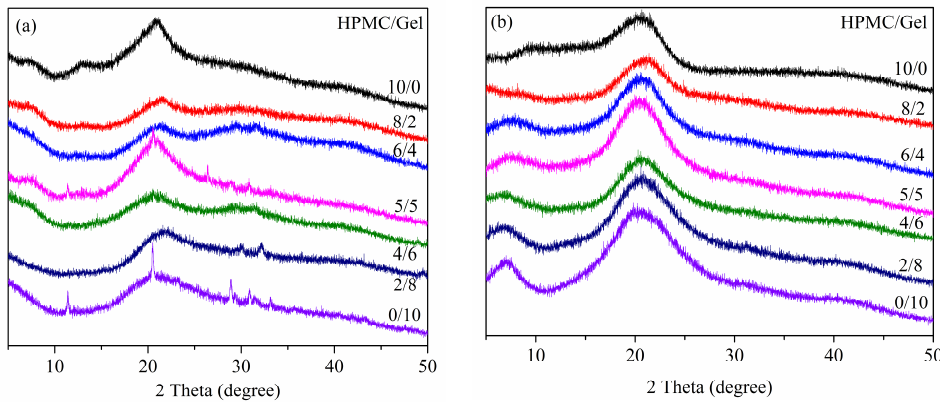
Figure 3. XRD patterns of HPMC and Gel blended film: ( a ) natural dry; ( b ) freeze dry.